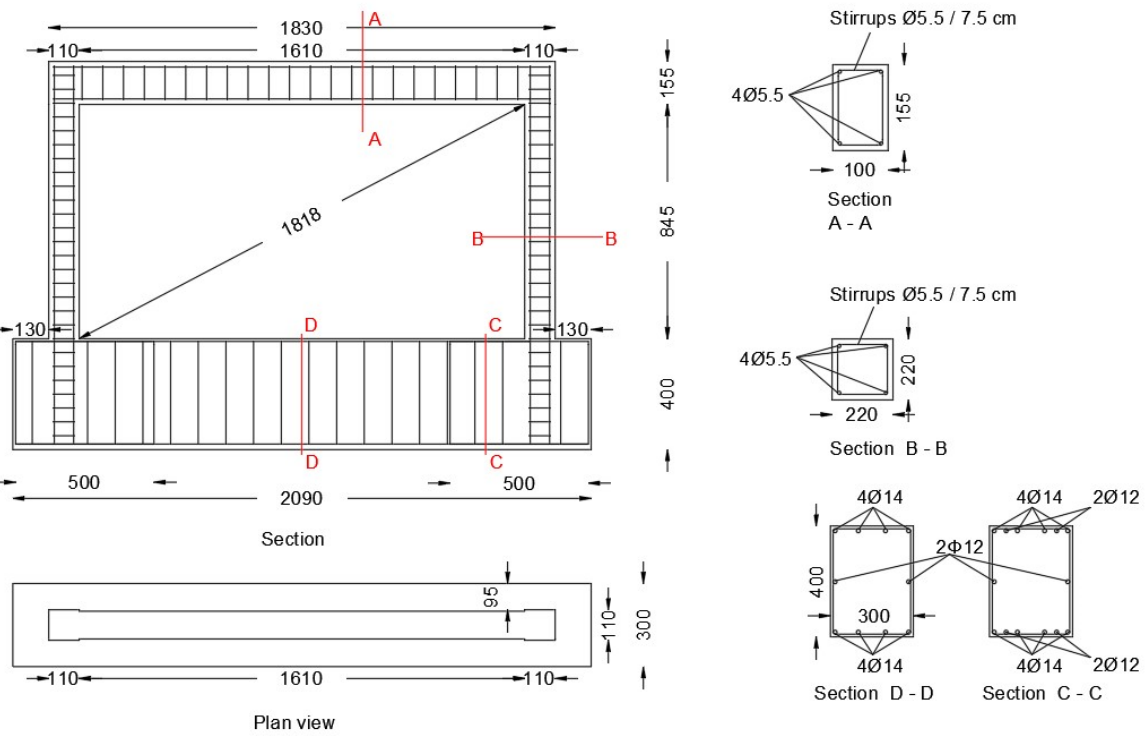
Figure 6. Structural details of the RC frame models hosting UMI tested at Aristotle University [23,44]. One such specimen with the code name F2N is formed with well ‐ built clay masonry of 60 mm nominal thickness by using clay bricks of nominal dimensions 60 mm × 100 mm